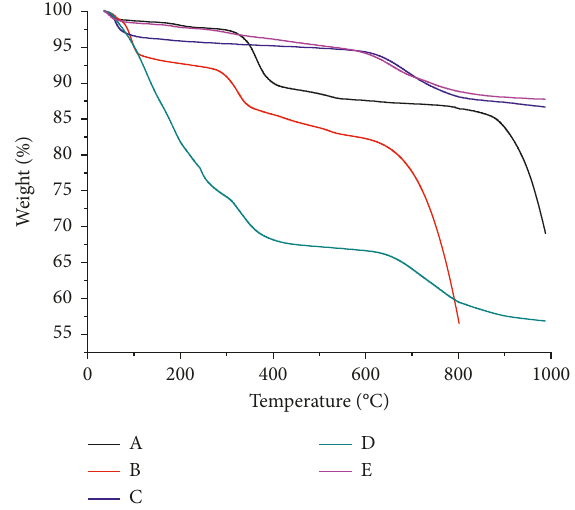
Figure 5: TGA of prepared